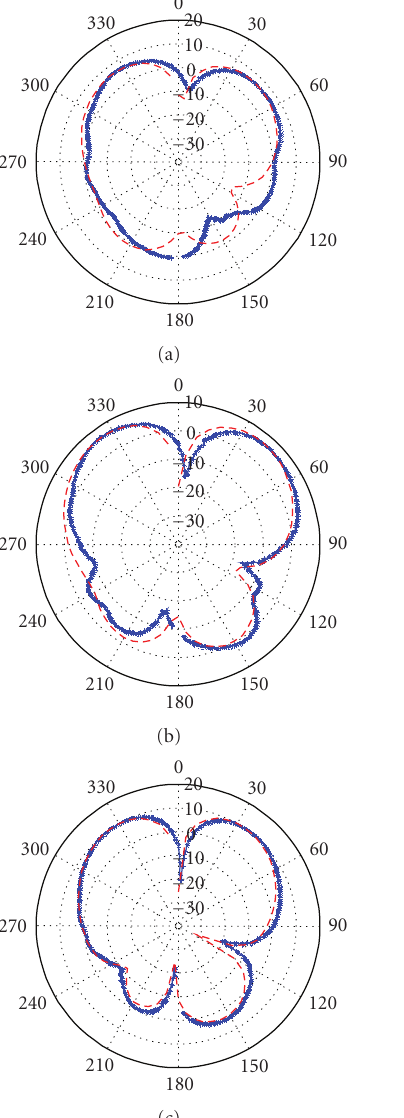
Figure 5: Measured (+) and simulated ( − ) cross-polarized radia- tion patterns for broadside mode (S11) in XZ-plane at (a) 1.7GHz, (b) 1.85 GHz, and (c) 2.1 GHz.